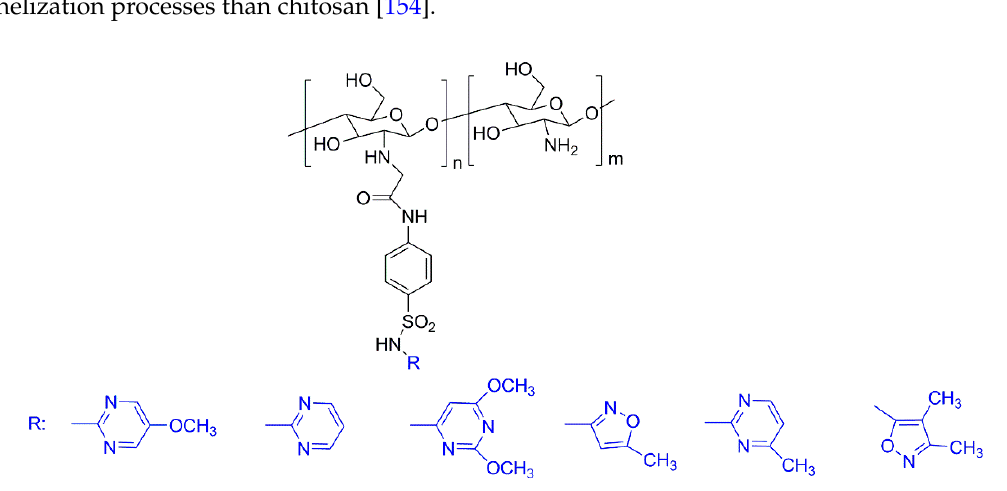
Figure 9. Structure of TMC.